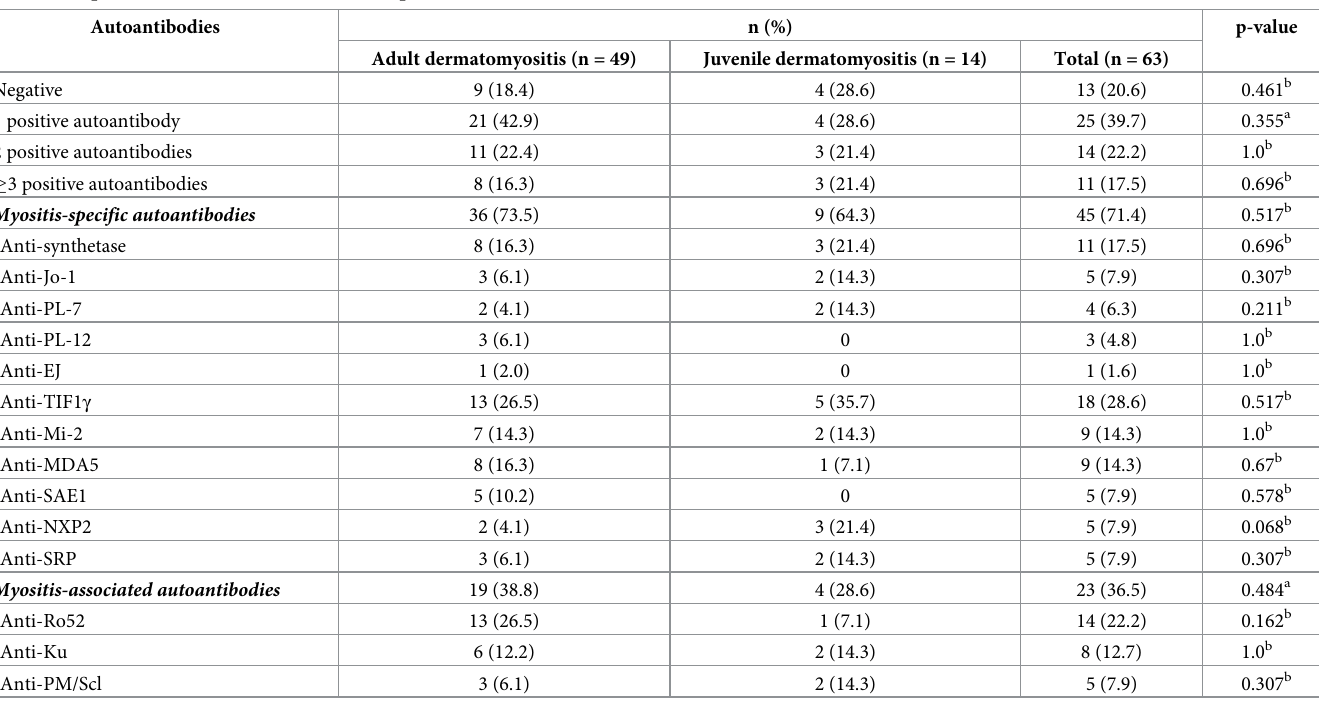
Table 4. The profile of autoantibodies of 63 tested patients (n = 63).